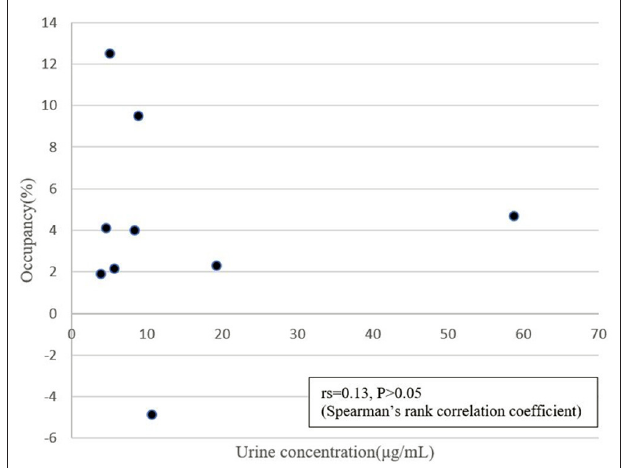
FIGURE 4 | Correlation between urine concentration and DAT occupancy in striatum (average of caudate and putamen) with 60mg of